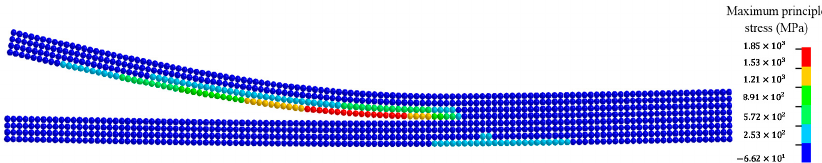
Fig. 22 Figure 22. Deformed configuration of the MMB model ( β = 0.5) at t = 30 ms.